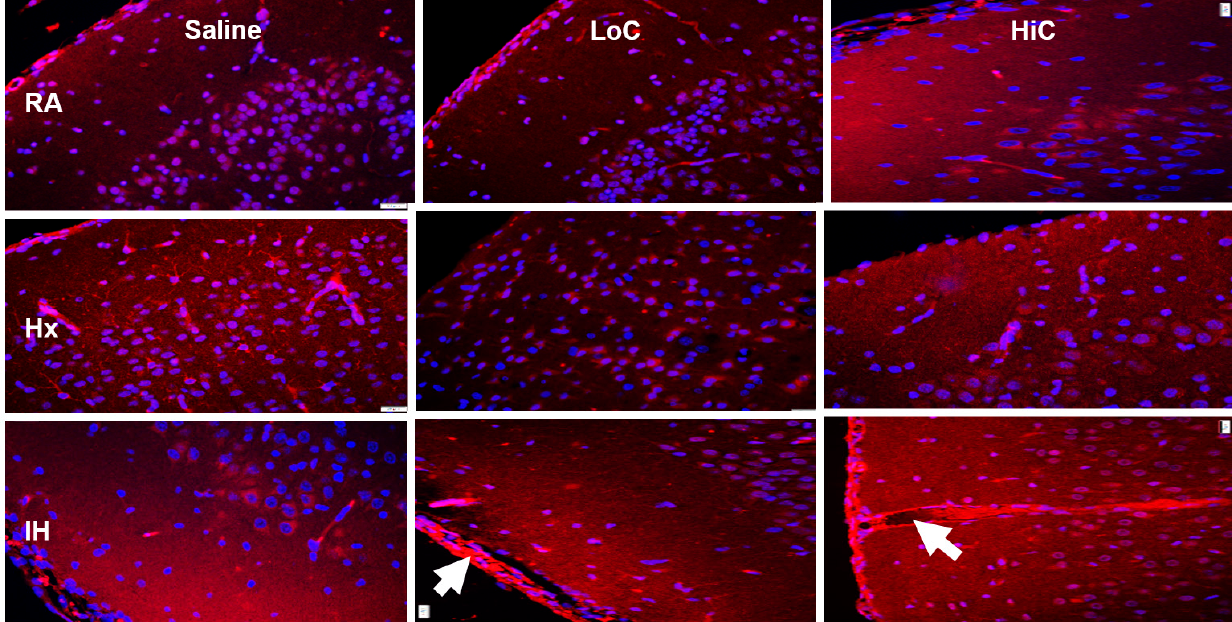
Figure 5. Representative caspase-3 immunofluorescence staining in the cerebral cortex at P14. Groups are as described in Figures 2. Images are 20× magnification, bar scale is 50 µm. Both LoC and HiC resulted in caspase-3 immunoreactivity in all oxygen environments. This may be due to its anti-proliferative effects.